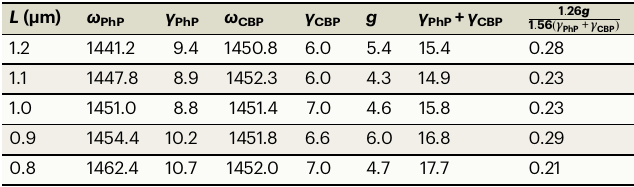
Table 1 | Parameters obtained by fi tting the experimental complex-valued spectra shown in Fig. 4b via the coupled harmonic oscillator